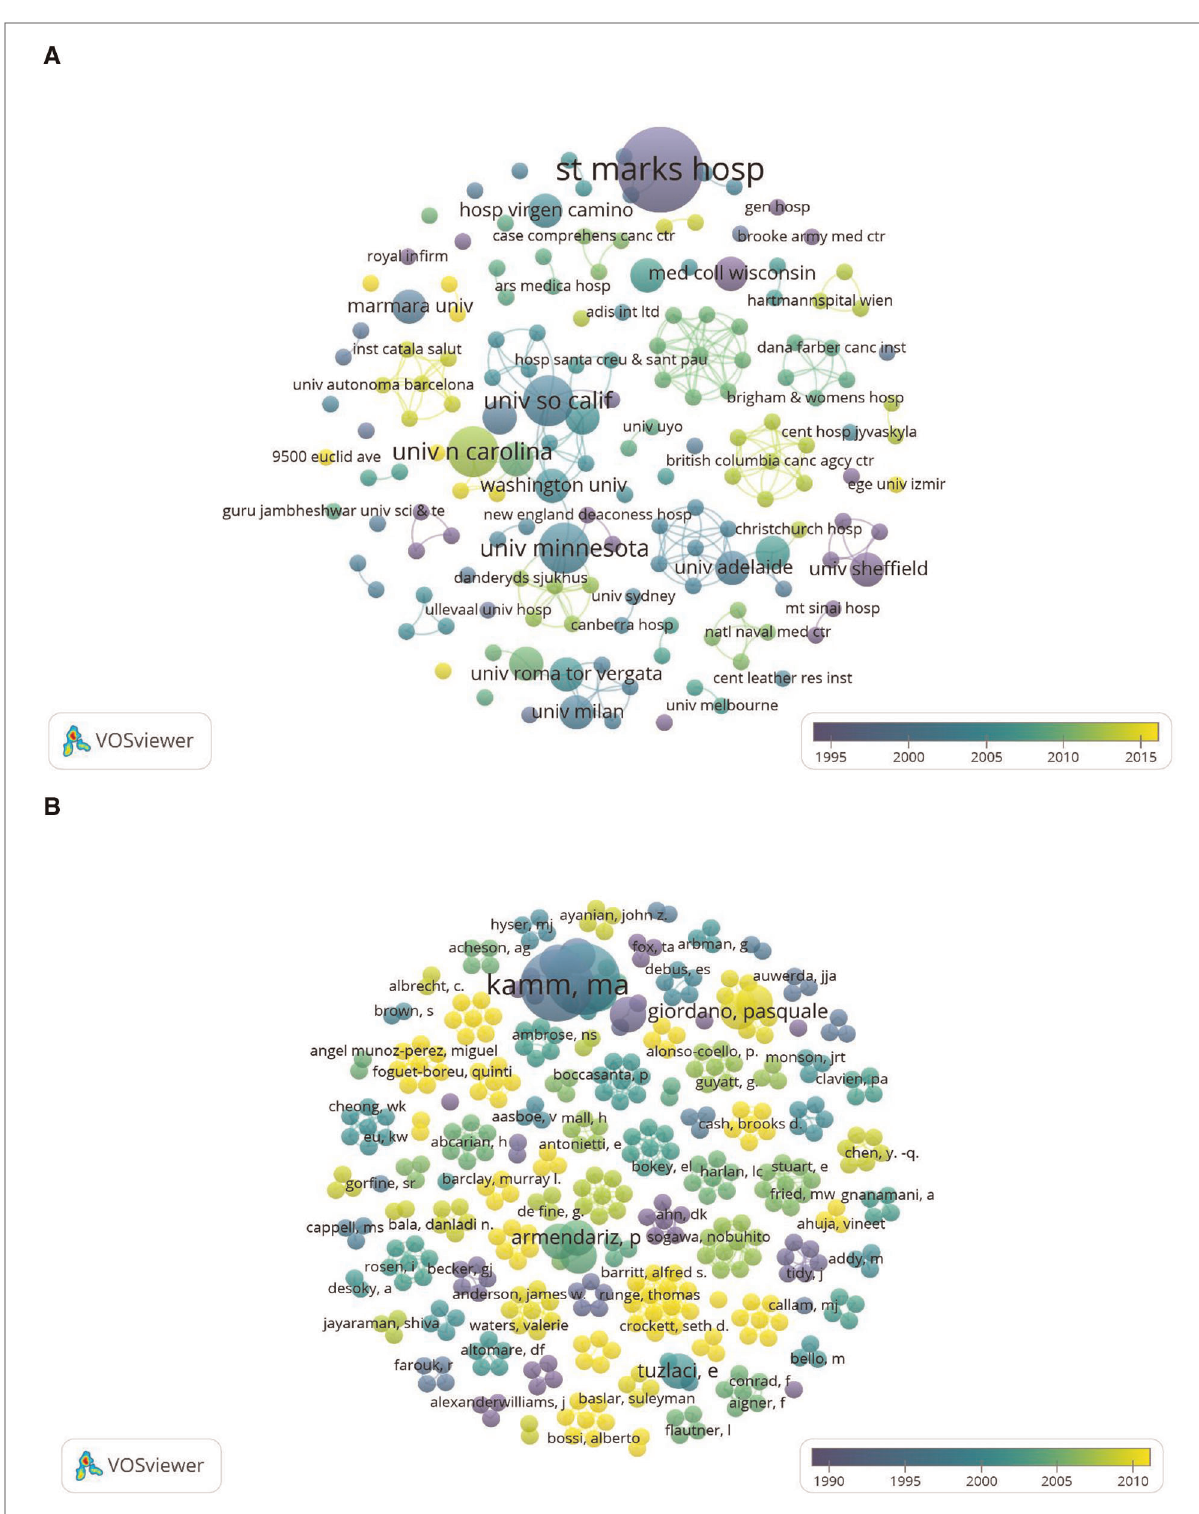
FIGURE 5 Publication status of authors and institutions of the 100 most-cited articles. (A) Institutions ’ cooperation coexistence diagram, (B) authors ’ cooperation coexistence diagram.